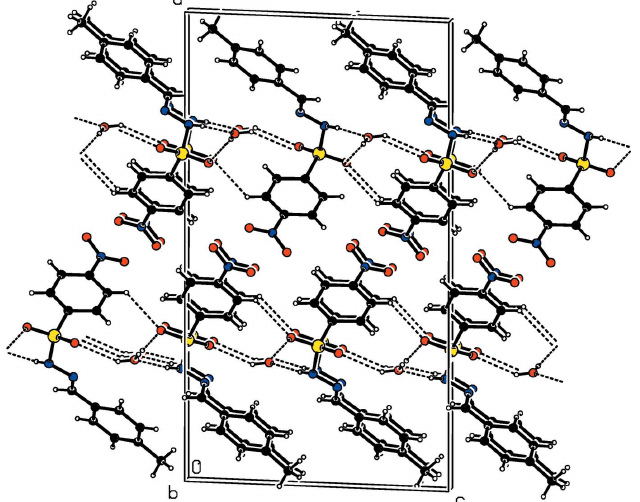
Figure 7 The crystal packing of compound (II), viewed along the a axis,with hydrogen bonds shown as dashed lines.